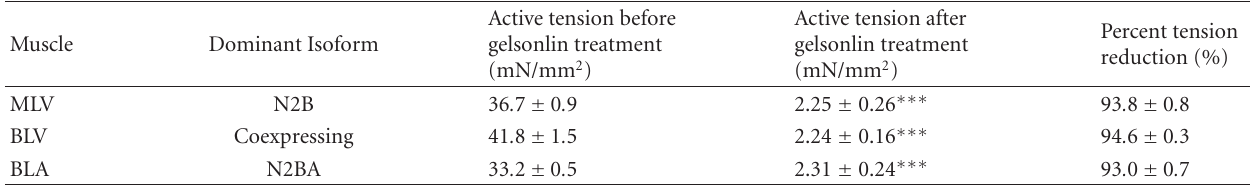
Table 1: Measurement of maximal active tension (pCa 4.5) before and after gelsolin treatment. Percent reduction not di ff erent